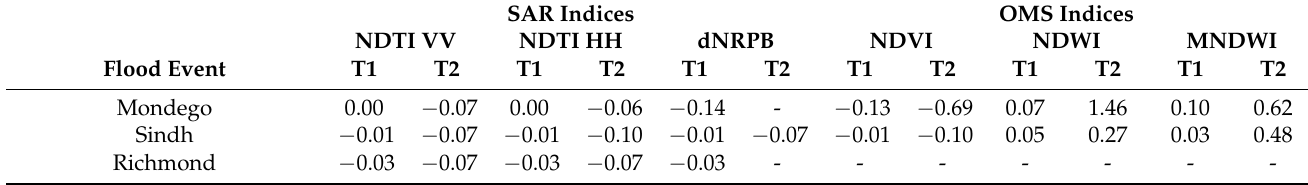
Table 5. Index-differencing thresholds of both SAR and OMS indices, for flood-related changes. SAR Indices